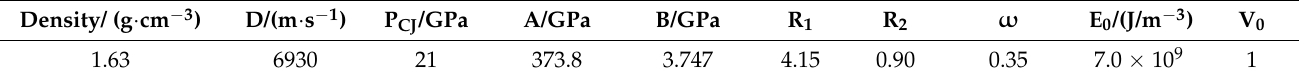
Table 2. Material parameters of TNT.